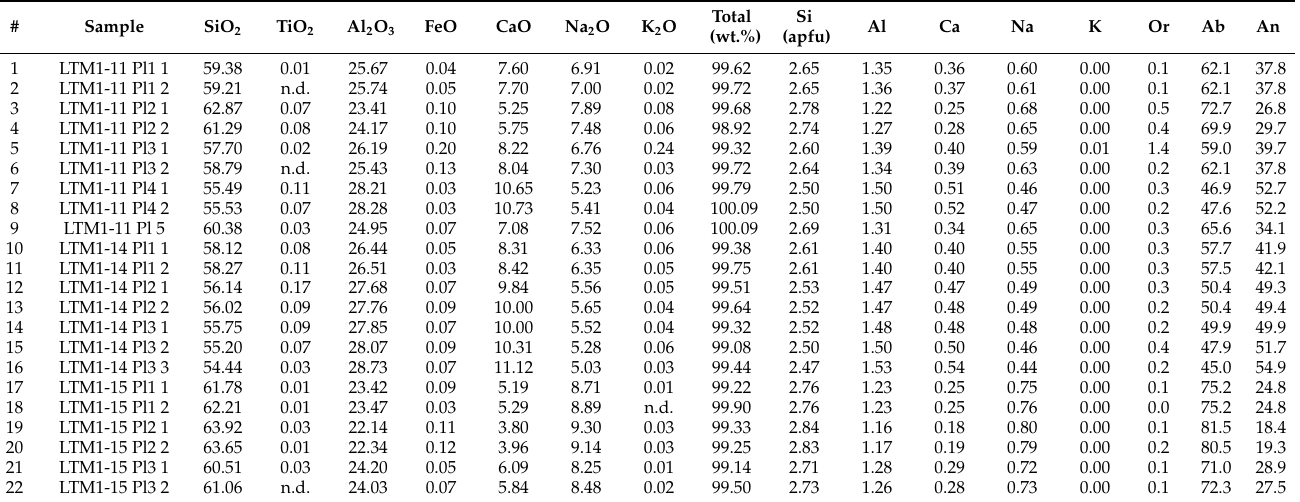
Table 3. Compositions of plagioclase in the orthopyroxenite zone of the Lotmvara-I sill, Kola Peninsula.